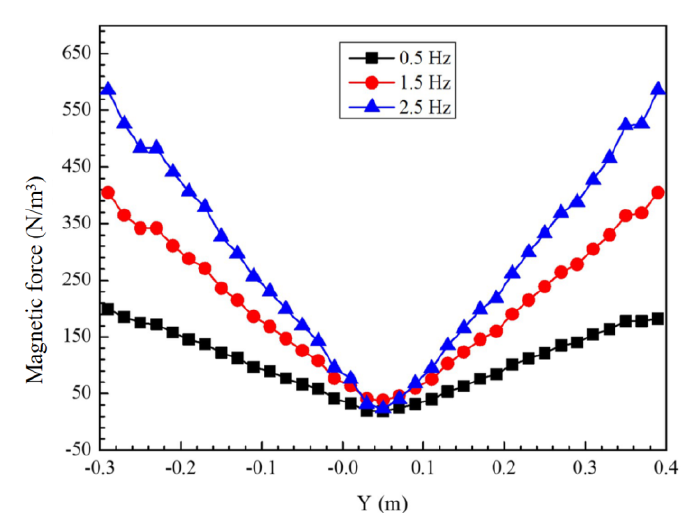
Figure 7. The magnetic force density distribution at different frequencies.